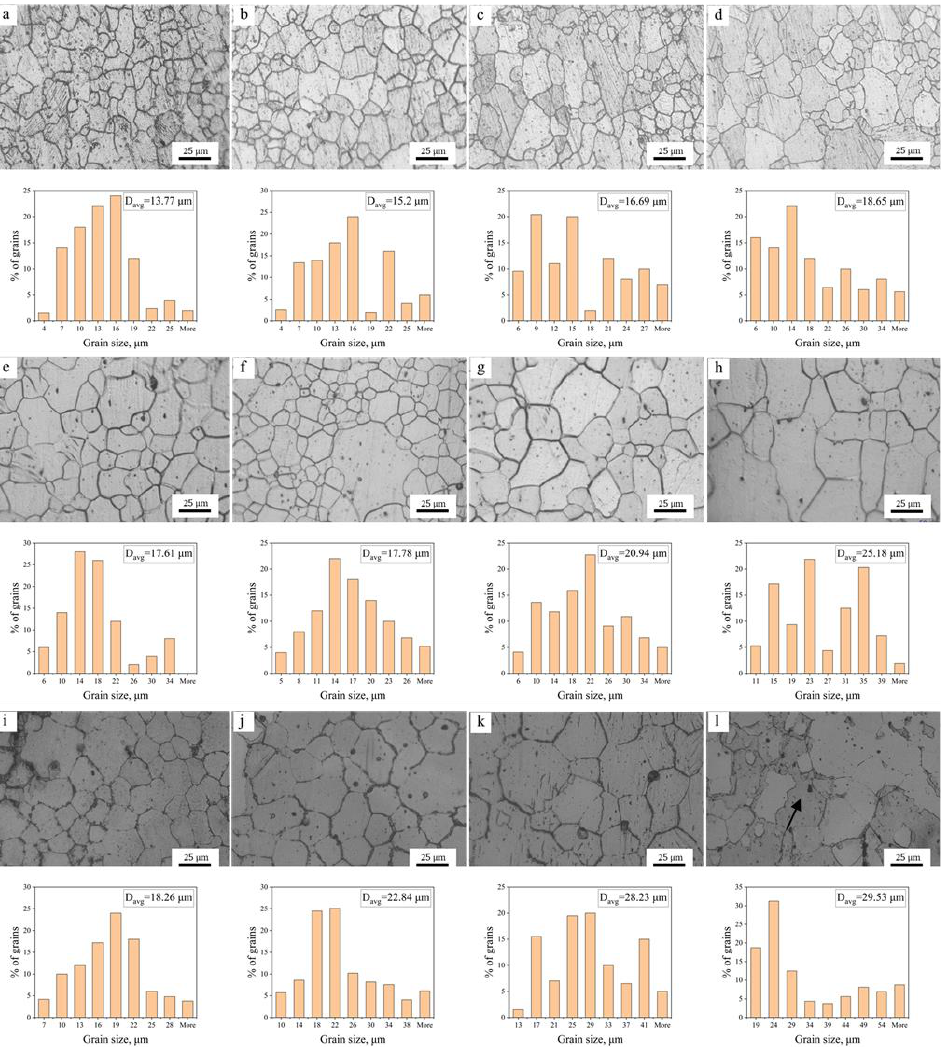
Figure 5. Optical micrographs of ( a – d ) AZ31, ( e – h ) AZ61, ( i – l ) AZ91 annealed at 400 °C for 12, 24, 48, and 72 h. The corresponding histograms of the particle size distribution are shown below each micrograph.